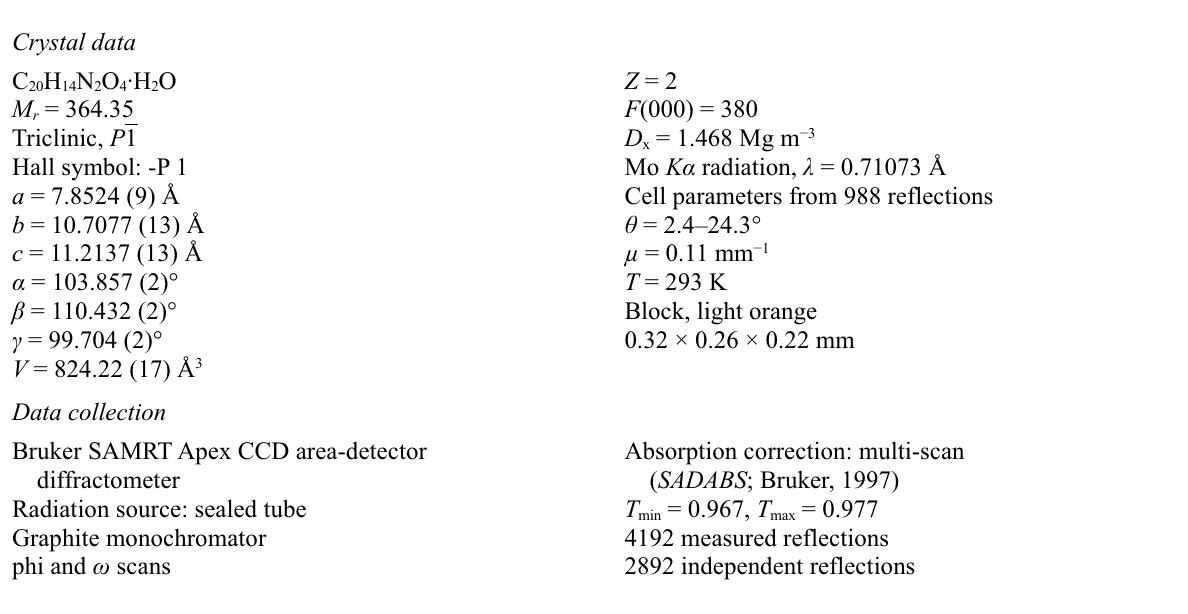
Figure 2 A packing diagram for (I). Hydrogen bonds are shown as dashed lines. 2 ′ -Amino-3,6-dihydroxyxanthene-9-spiro-1 ′ -isoindolin-3 ′ -one